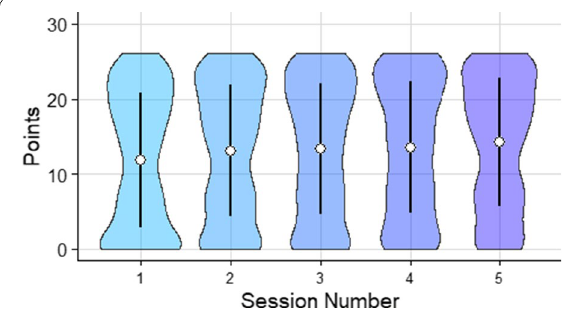
Fig. 11 Violin plot illustrating points earned per experimental testing session ( N Session 1 = 892, N Session 2 = 900, N Session 3 = 898, N Session 4 = 895, N Session 5 = 809). White circles indicate the mean and error bars represent 1 standard ±